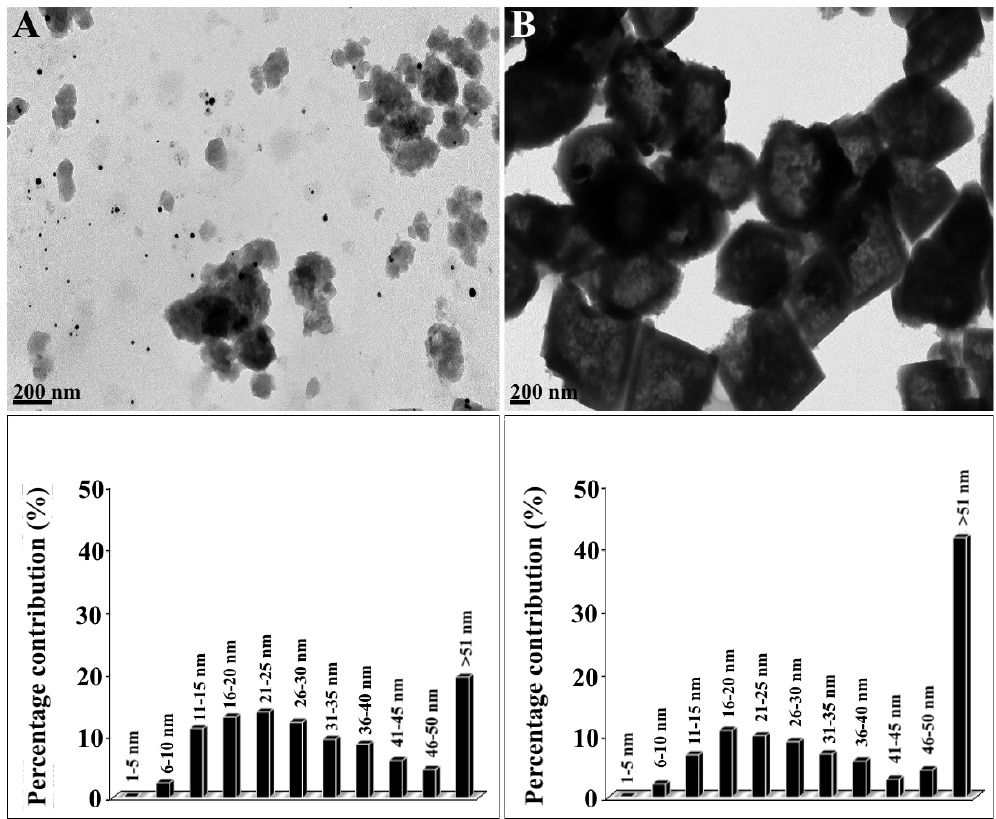
Figure 10. TEM images and metal nanoparticle size distribution on ( A ) Red-Mi-Co 20 SiBeta and ( B ) Red-Me-Co 20 SiBeta.